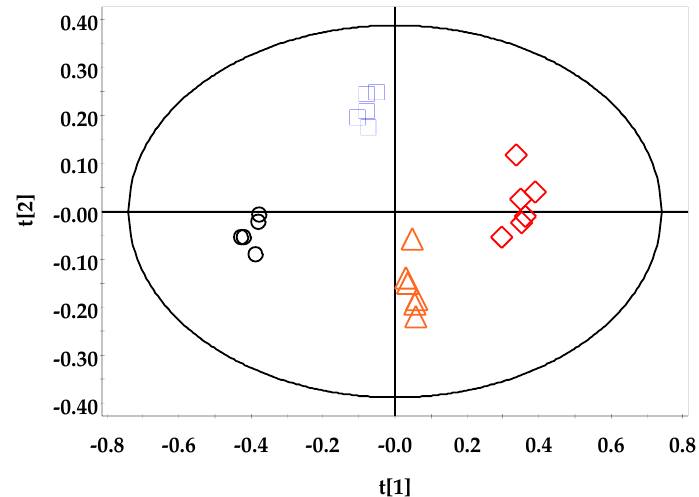
Figure 8. OPLS-DA score plot based on the 1 H-NMR spectra of the DSS-treated group and control group. ○ : DSS 0%; □: DSS 2%; △ : DSS 3.5%; ◇ : DSS 5% ( R 2 X = 0.738, R 2 Y = 0.919, and Q 2 = 0.258).